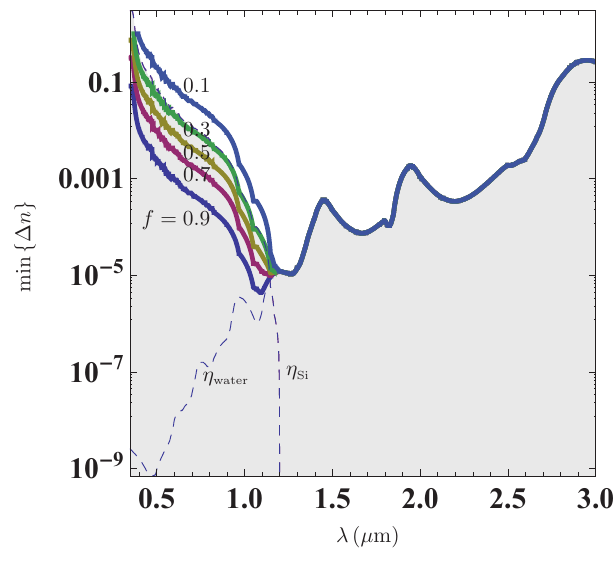
Figure 2. Ultimate detection limit for a resonance in a silicon structure infiltrated by water. The different traces show results for varying values of the light-liquid overlap f . The dashes lines show the imaginary part of the refractive index for water and silicon,